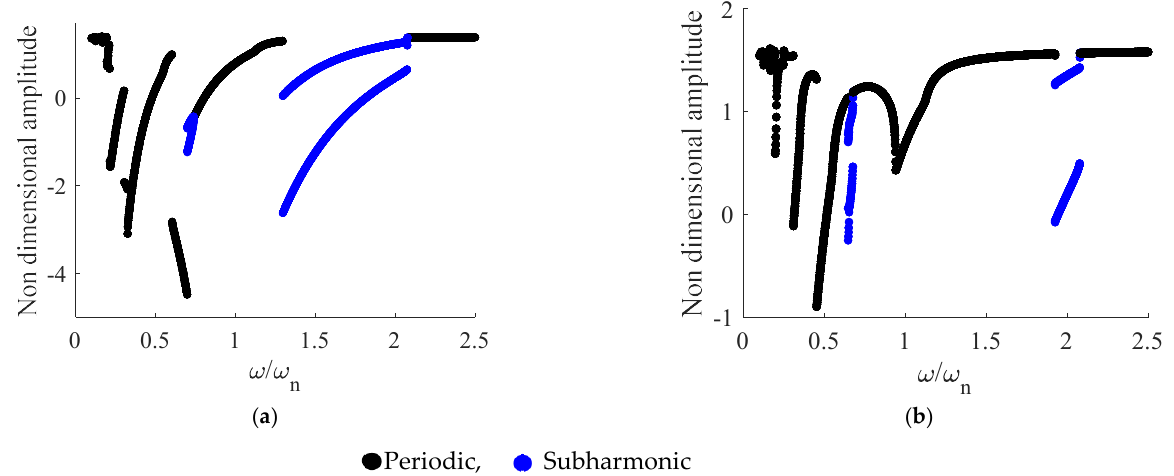
Figure 6. Bifurcation diagram based on ( a ) backward and ( b ) forward simulations, case